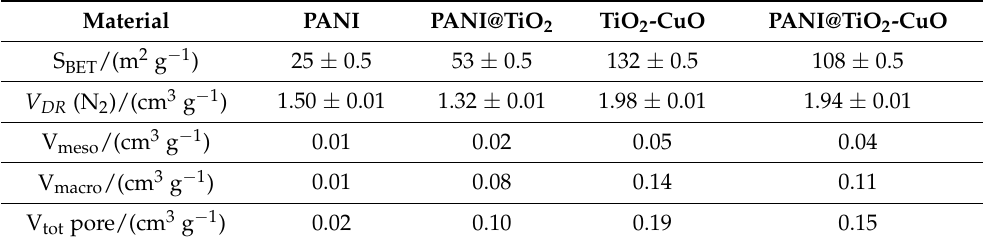
Table 1. Materials’ textural characteristics obtained from N 2 adsorption-desorption data.